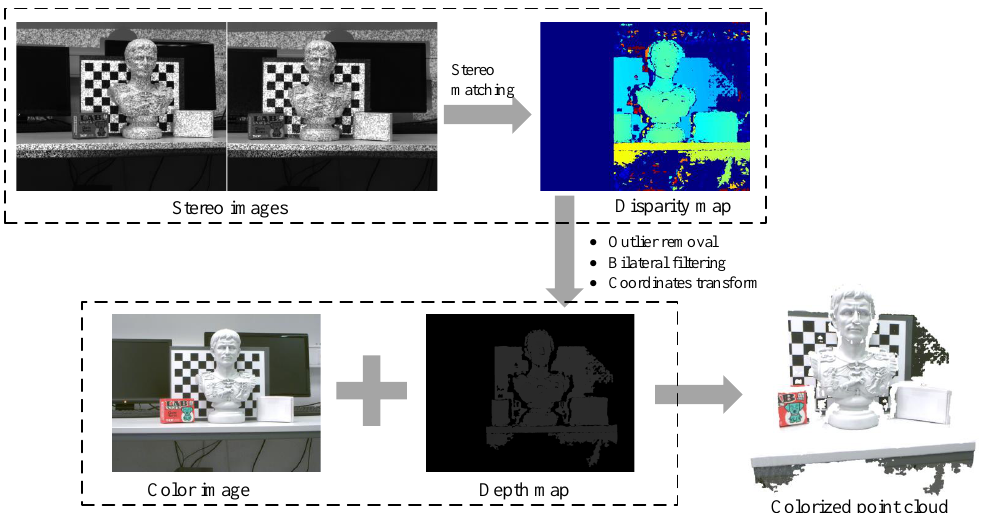
Figure 4. Data preprocessing is performed to convert raw triple images including stereo pairs and the color image into aligned RGB-Depth